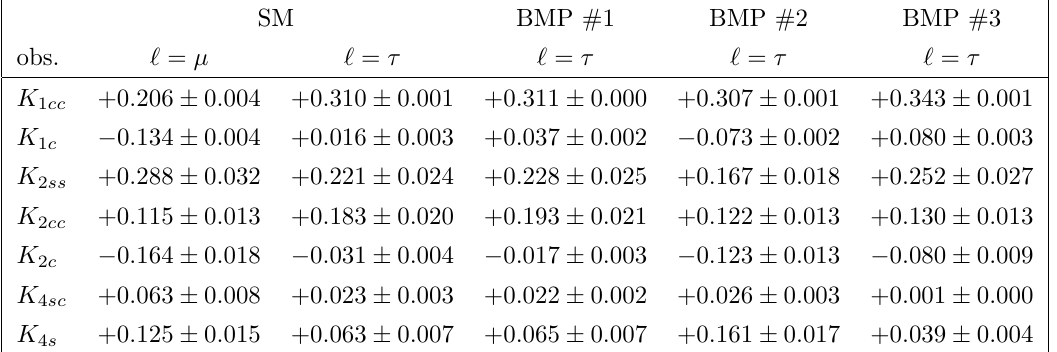
Table 1 . Predictions for the angular observables in the SM and in the NP benchmark point.